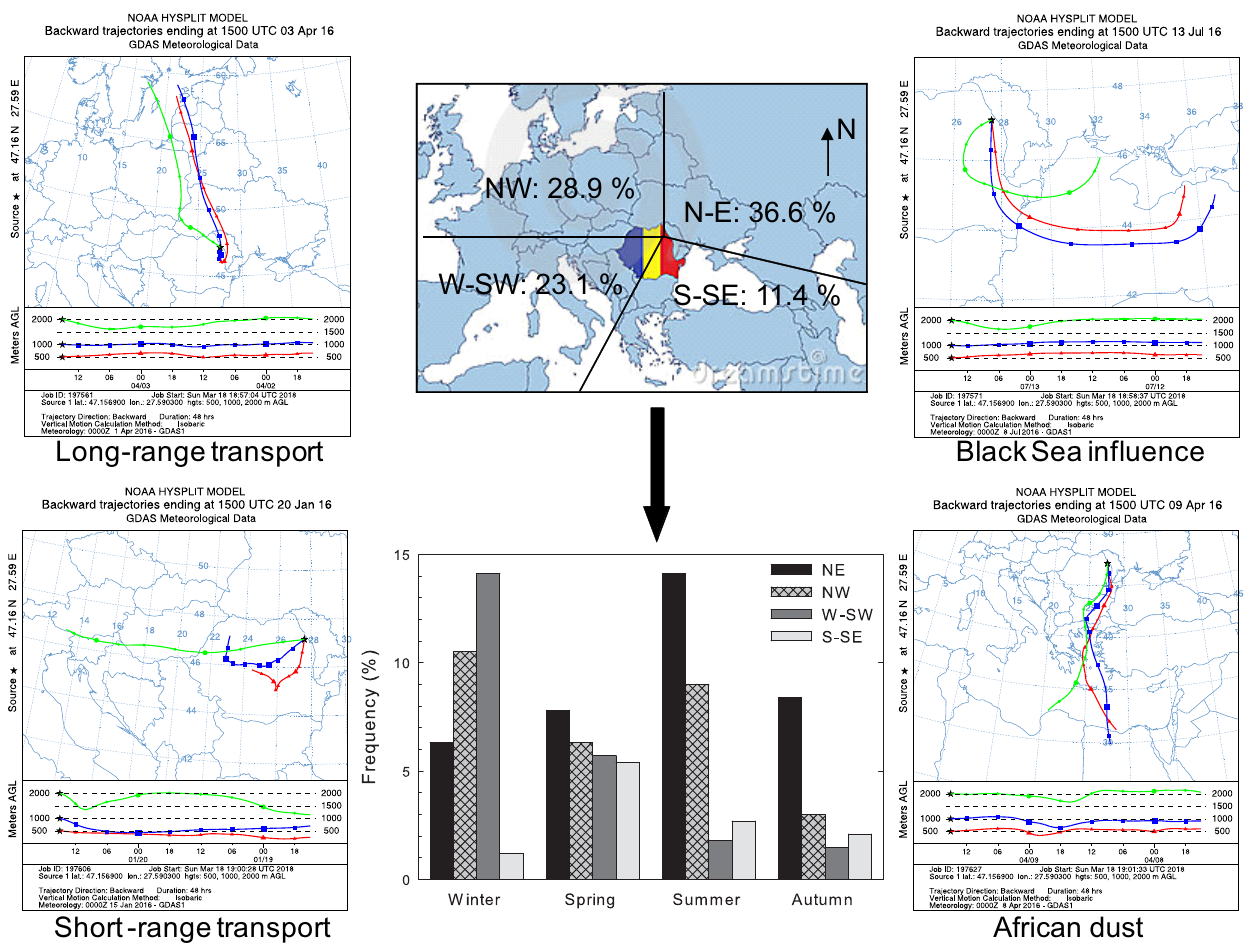
Figure 1. Sector contributions identified from classification of 2-day back trajectories of air masses ending at Iasi and representative backward trajectories of long- and short-range transport, Black Sea influence, and African dust (shown trajectories correspond to sampling events). Table 1. Basic statistics for the PM 10 and PM 2 . 5 fractions’ mass concentrations determined over the investigated period ( n = 84 sampling events) in Iasi, north-eastern